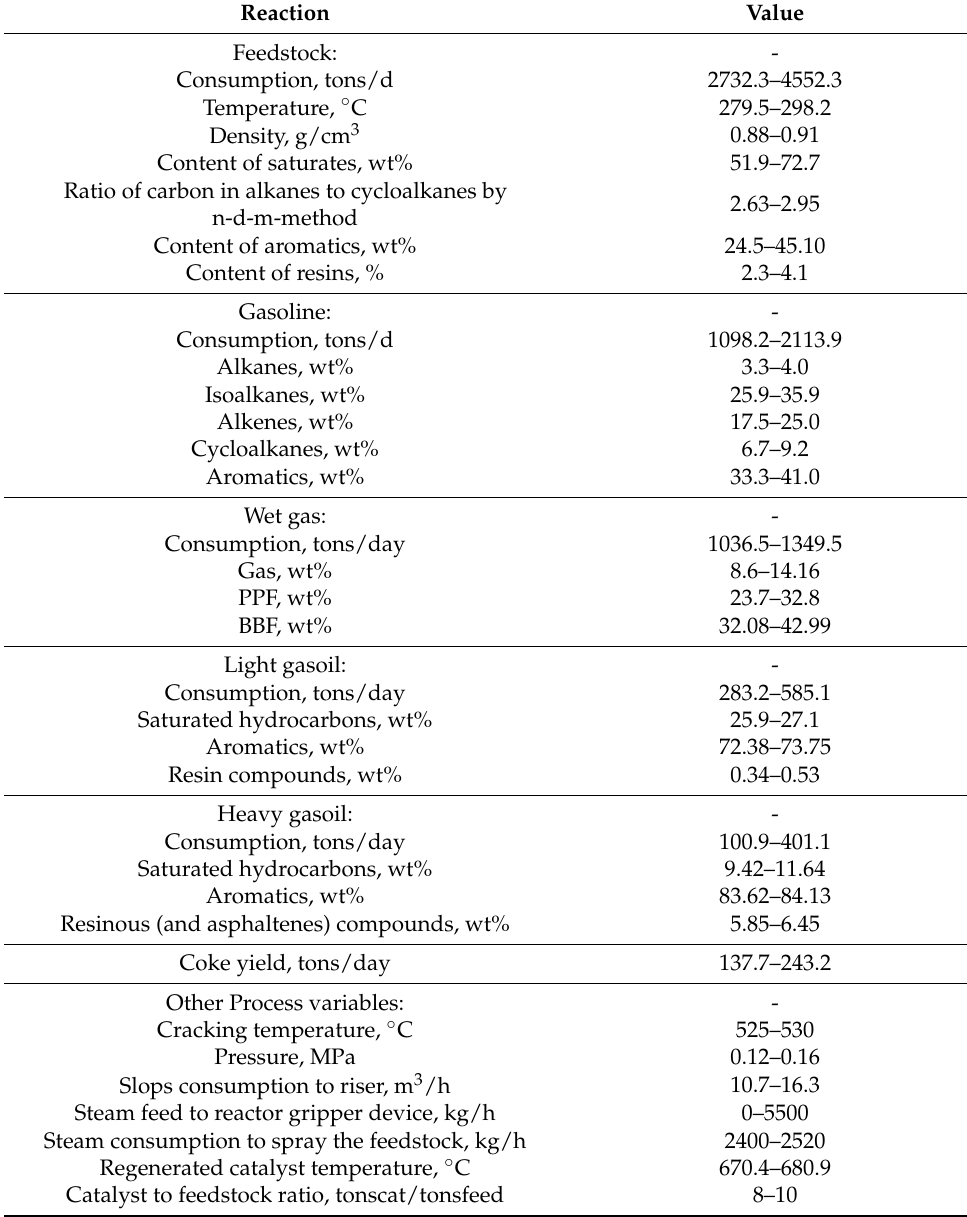
Table 3. Process variables, feedstock and products properties to develop the